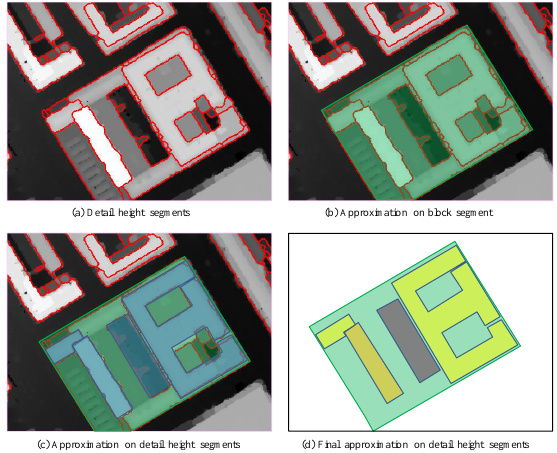
Figure 9: Enhanced prismatic model by including different height levels of building into